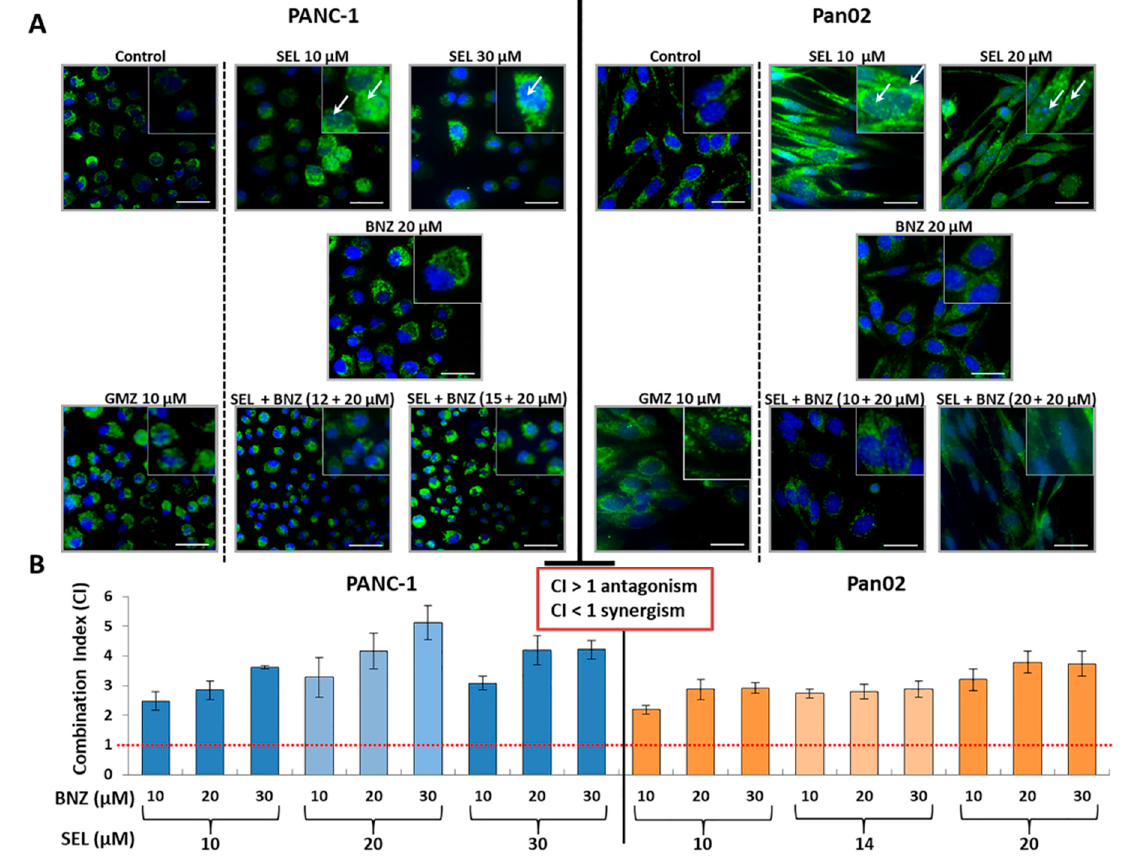
Figure 3. Expression of AIF: immunofluorescence analyses and effect of benzamide. ( A ) Immunofluorescence analyses of AIF expression in PANC-1 and Pan02 pancreatic cells treated with selenite, GMZ, BZD and selenite + BZD at different concentrations. Representative images of mitochondrial staining and nuclear translocation depending on the treatment analyzed. Square × 2 magnification of the principal image. ( B ) Combination index (CI) of PARP inhibition studies using BZD and selenite + BZD. GMZ (gemcitabine); SEL (sodium selenite); BNZ (benzamide).